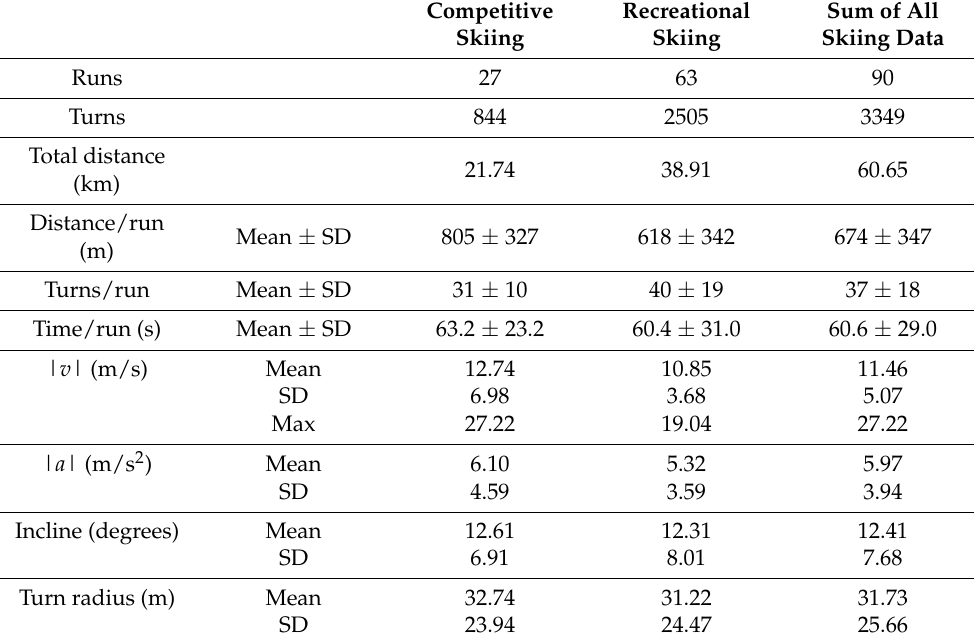
Table 2. Characteristics of the data acquired (all data, competitive and recreational skiing) from the ground truth measurement system. Nomenclature: speed (| v |), acceleration (| a |), trajectory incline (incline) kilometers (km), meters (m), seconds (s) and standard deviation (SD). Competitive Recreational Sum of All Skiing Skiing Skiing Data Runs